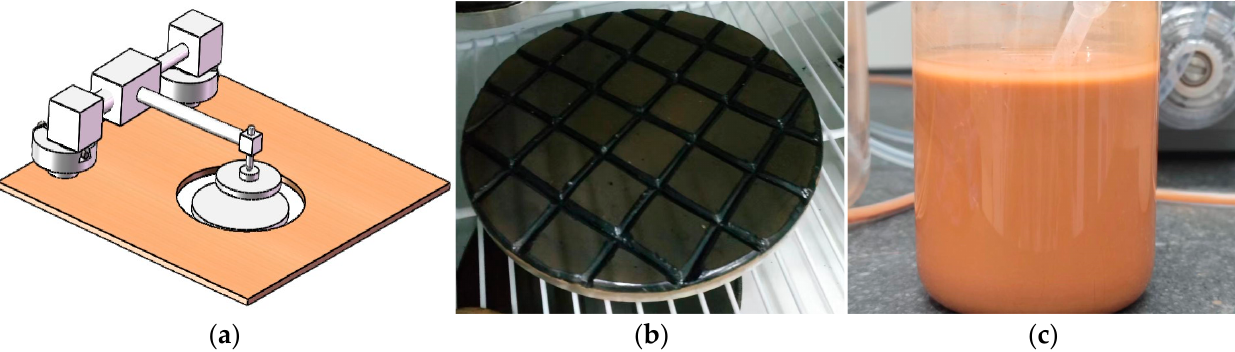
Figure 1. Polisher and auxiliary materials: ( a ) polisher diagram; ( b ) optical pitch; ( c ) cerium oxide polishing slurry.